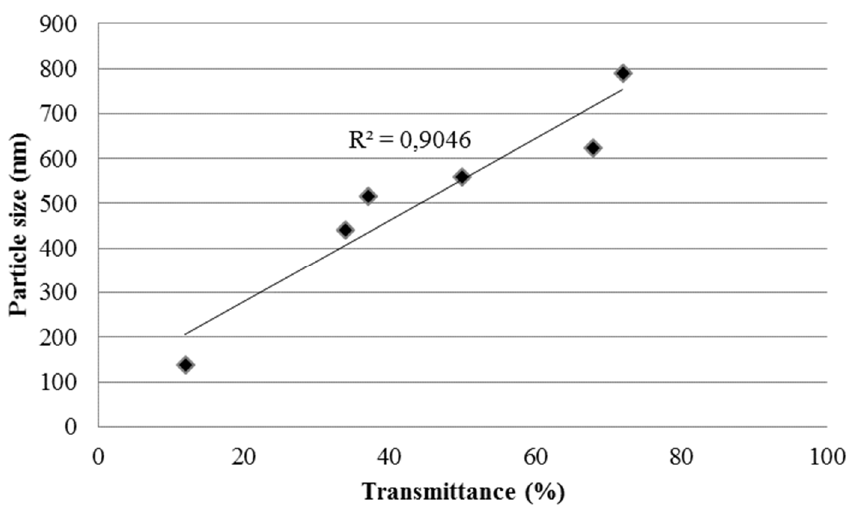
Figure 3. Average particle size vs. transmittance for surfactant mixtures from non-ionic surfactants with different structures.